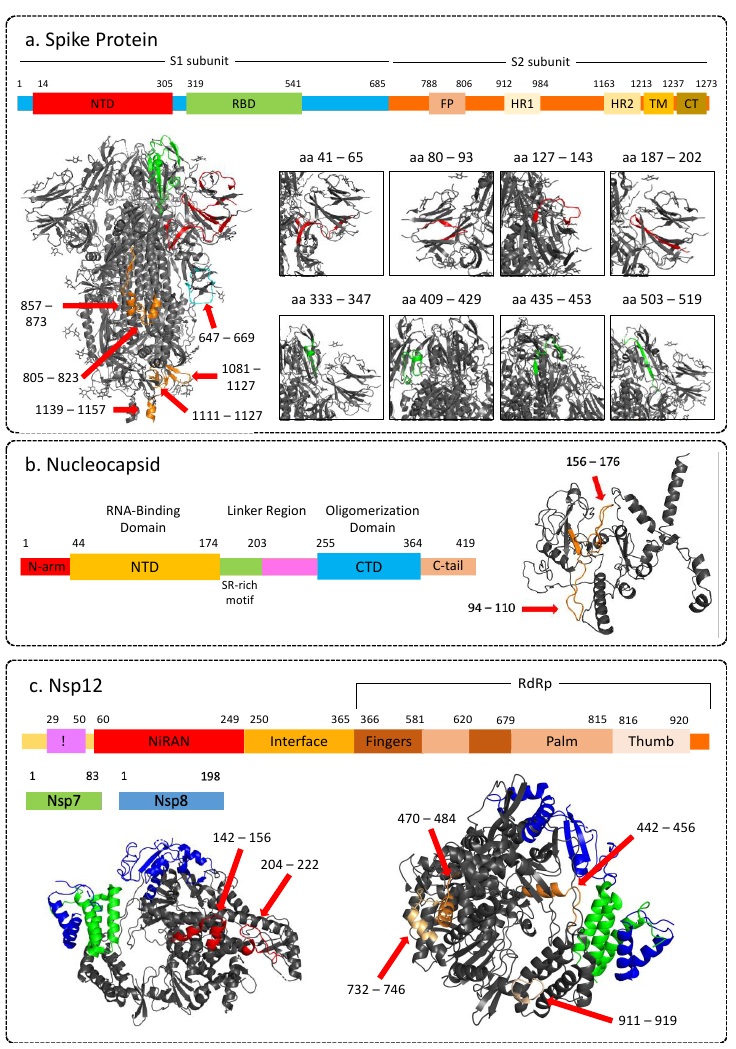
Figure 5. Representative images showing 3D structure of SARS-CoV-2 proteins highlighting immunogenic peptides, along with corresponding linear structure. ( a ) Spike protein (PDB: 6VXX); ( b ) Nucleocapsid (3D structure modeled by Zhang lab using I-Tasser). ( c ) Non-structural protein 12 (RNA-dependent RNA-polymerase) in complex with NSP7 and NSP8 (PDB: 6M71). NTD: N-terminal domain; RBD: Receptor binding domain; FP: Fusion; HR: Heptad repeat; TM: Transmembrane region; CT: Cytoplasmic tail; CTD: C-terminal domain. The 3-D structures of the proteins were visualised using PyMOL (version 2.5.2) [47].